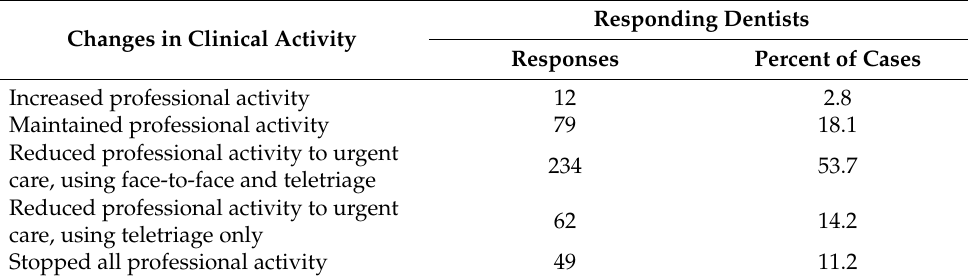
Table 4. Changes in the clinical activity of the responding dentists during the initial wave of COVID-19 ( n =